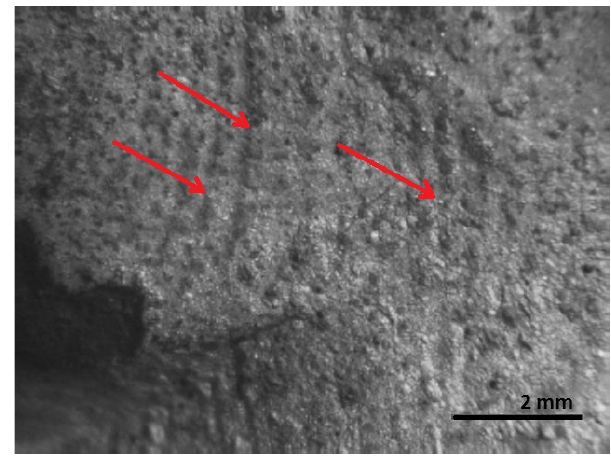
Figure 18. Fracture area: the area of gradual crack growth.